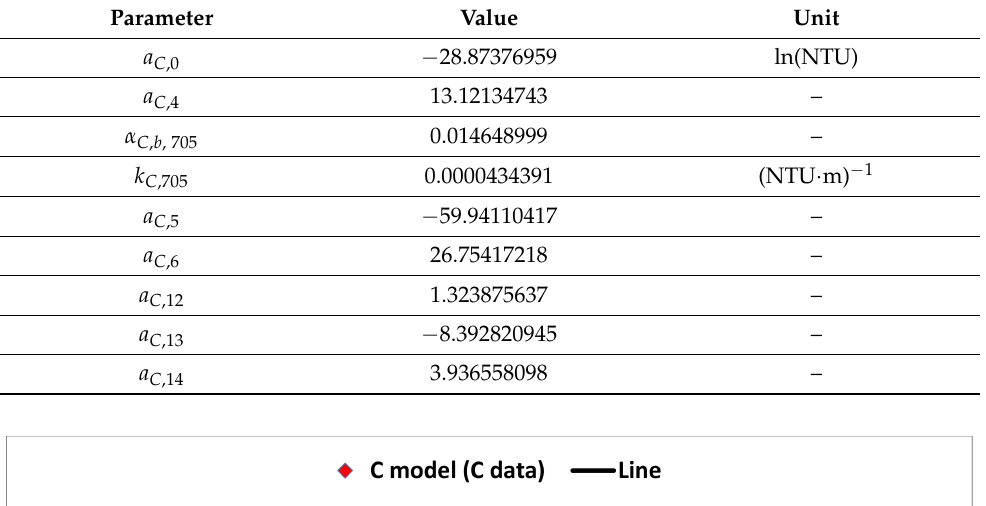
Table 3. Values of the model (17) parameters.